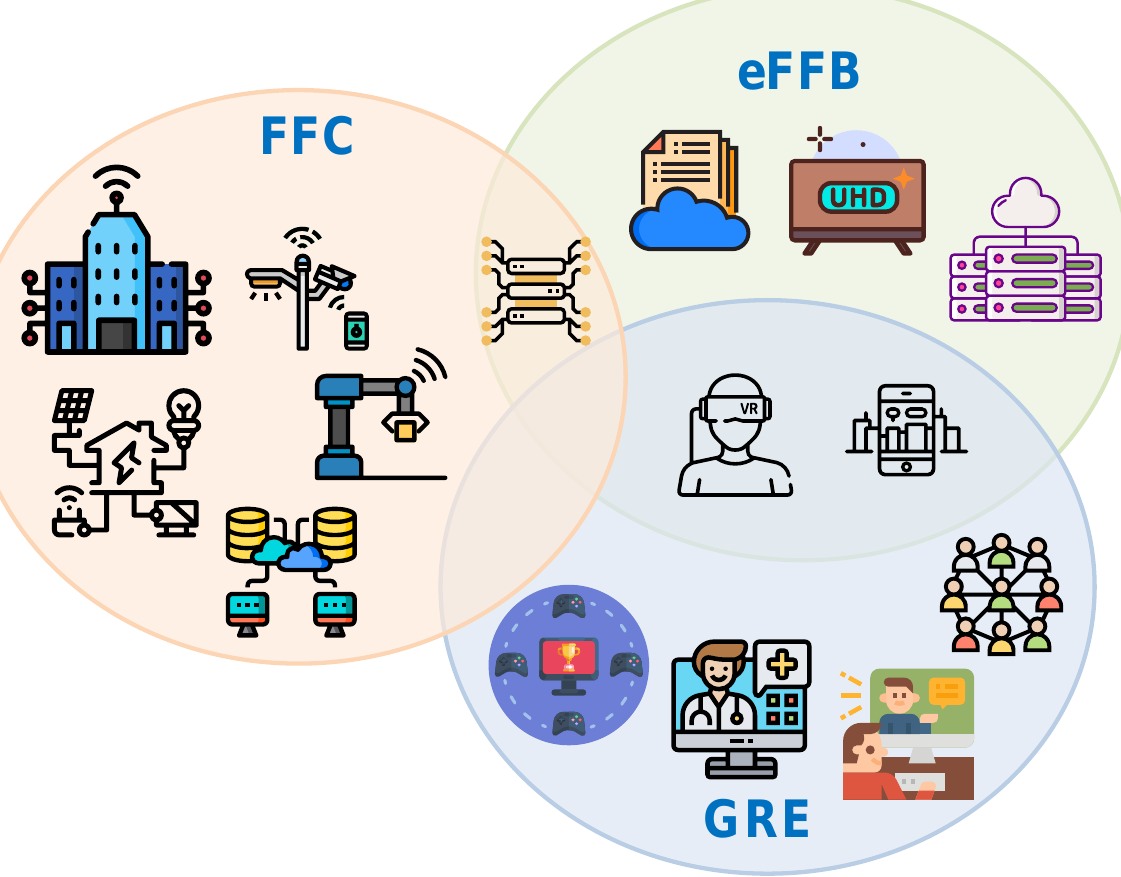
Figure 3. Representative services for the three F5G service families.